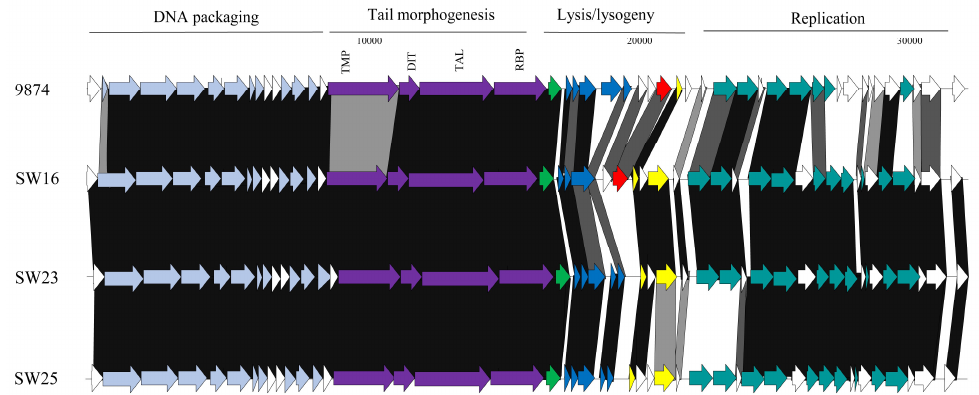
Figure 2. Genomic comparisons of representative 987 phages from this study and their most distant relative within the 987 group from previous studies, 9874. The functions of the gene modules are indicated above the diagram and correspond to the colour-coded arrows as follows: pale blue arrows represent genes encoding DNA packaging and capsid morphogenesis functions; purple arrows indicate tail adhesion/injection device components including the tape measure protein (TMP), Dit, Tal, and receptor binding proteins (RBPs); bright green arrow indicates a serine acetyltransferase-encoding gene; dark blue arrows indicate host lysis functions; red arrows indicate the presence of transposase-encoding genes; yellow arrows represent repressor/anti-repressor encoding genes; and teal green coloured arrows represent genes encoding predicted DNA replication functions. Where arrows are joined by a black shaded area, the represented gene products are between 90% and 100% similar at the aa level; dark grey indicates 70–89% similarity and light grey indicates 50–69% aa identity between the gene products. Unshaded regions represent those possessing less than 50% aa